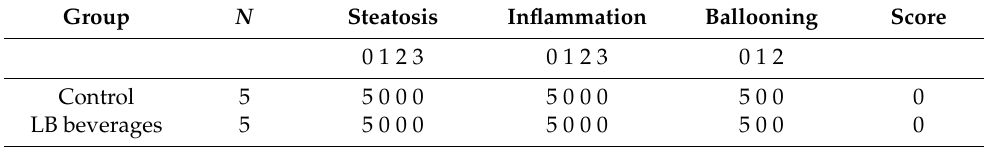
Figure 8. Histological analysis of the liver with hematoxylin and eosin staining. The numbers 1–5 indicate each rat in the control group ( n = 5) or Lactobacillus group ( n = 5). Control; control group, LB; Lactobacillus beverage group. The scale bar represents 100 µ m. Table 6. NAFLD activity scores in control and Lactobacillus beverage